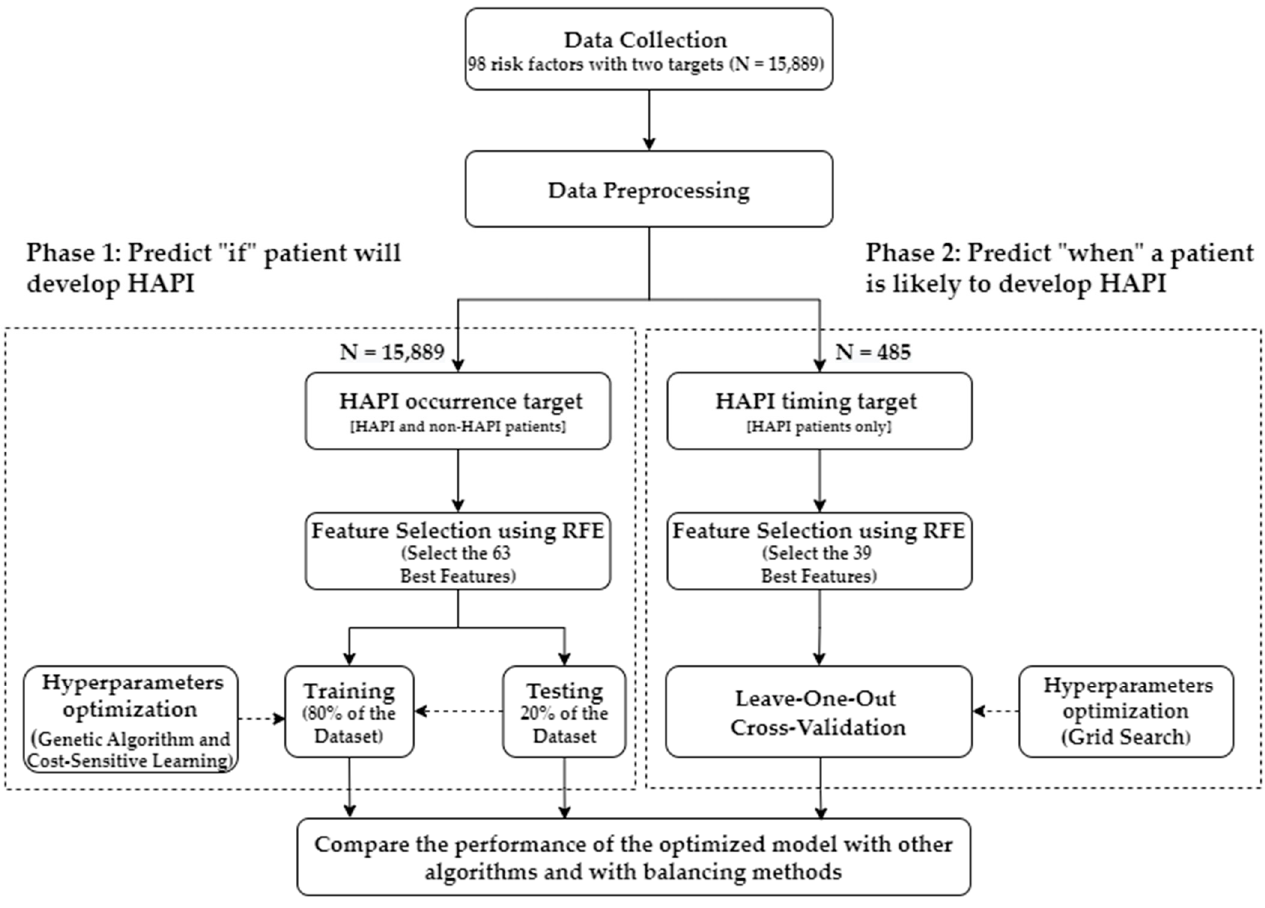
Figure 2. The framework of the proposed approach. Table 1. Dataset distribution in phases 1 and 2.